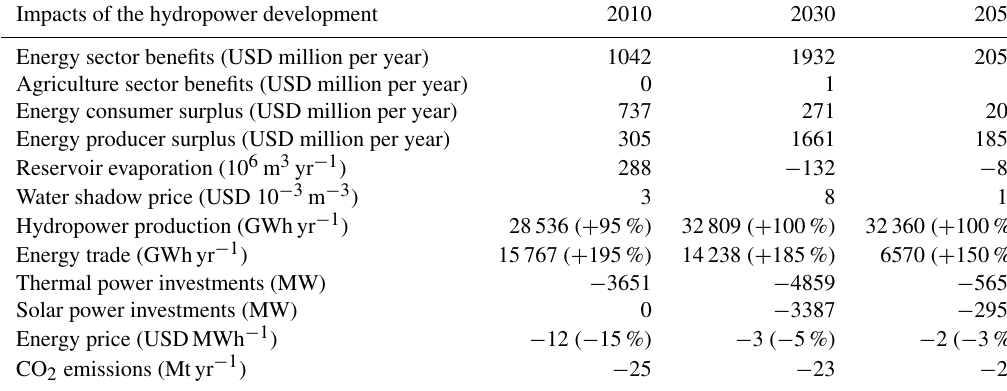
Table 10. Impacts of the hydropower development plan. Results are shown as the difference with and without the hydropower development plan for the 2010, 2030, and 2050 scenarios. Sector benefits exclude construction costs.